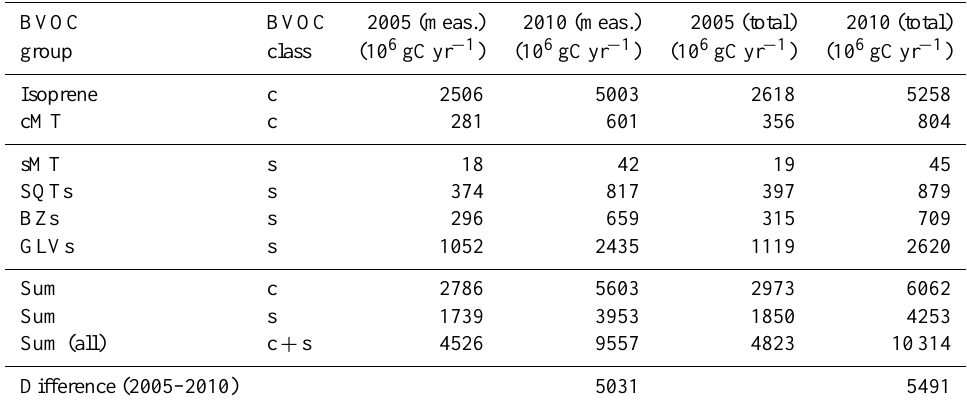
Table 2. Annual BVOC emission estimates in Beijing (city-level) for the year 2005 and 2010, modeled in hourly resolution from leaf level emissions from the Beijing survey as described in the text. Abbreviations of BVOC groups are as follows: cMT constitutive monoterpenes; sMT stress-induced monoterpenes, SQTs sesquiterpenes; BZs benzenoids; GLVs green leaf volatiles; BVOC class: c refers to constitutive; s refers to stress-induced. Meas.: BVOC estimates based on the 22 plant species measured. Total: BVOC estimates including estimates from plant species not measured (see Table 1) as well as Robinia pseudoacacia based on data provided in Yang et al. (2005). The differences of BVOCs between pre-Olympic (2005) and post-Olympic (2010) measurements are reported below the estimates of the total BVOCs for the year 2010 measured and total, respectively. BVOC BVOC 2005